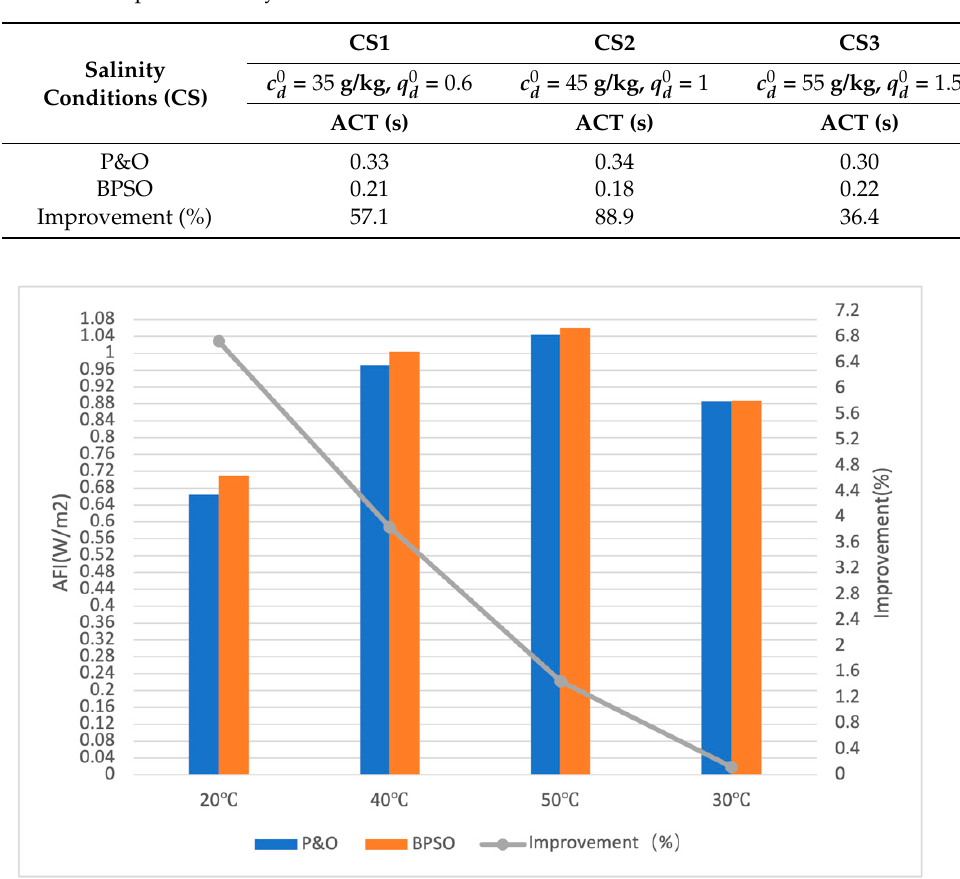
Figure 5. Bar plot of comparative between PSO and